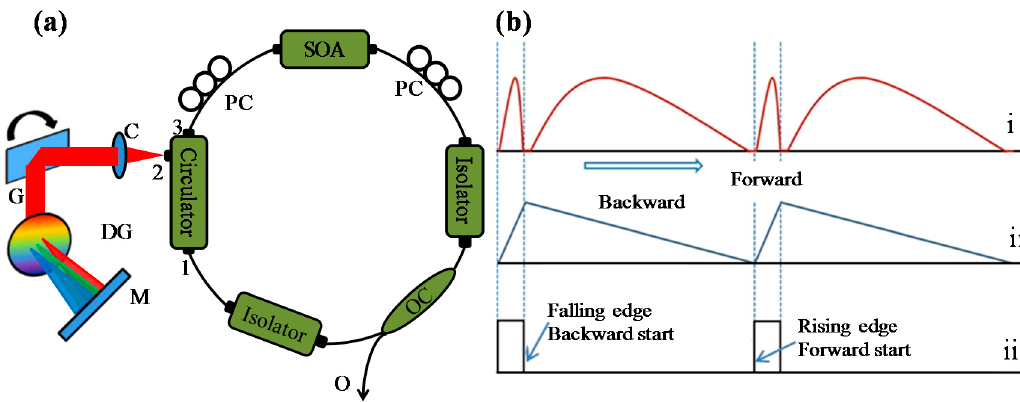
Figure 1. Schematic and timing diagram of the wavelength swept laser. ( a ) Schematic diagram of a galvo filter–based wavelength swept laser. C: collimator, DG: diffraction grating, G: galvo scanner,